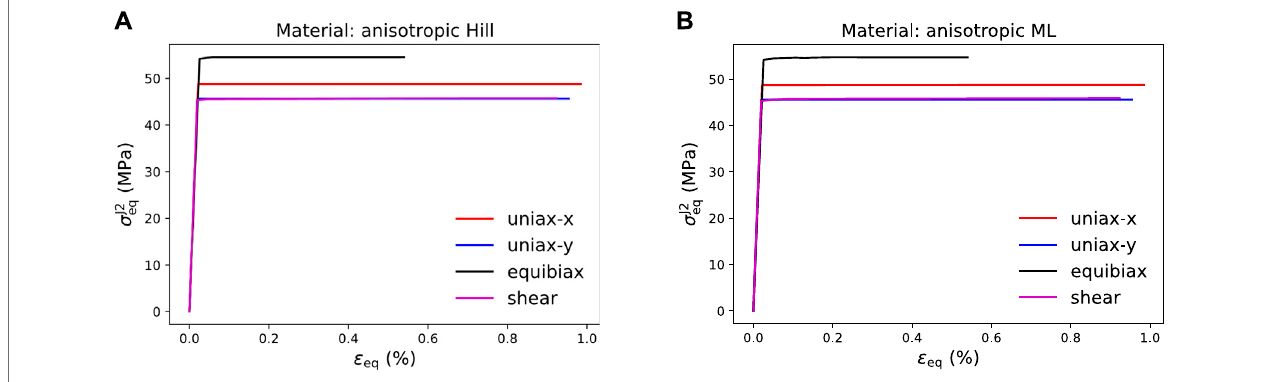
FIGURE 12 | Stress-strain curves obtained for elastic-ideal plastic material behavior under the loading conditions speci fi ed in the legend. (A) Equivalent J2 stress vs. equivalent total strain for Hill-type yield function, (B) Equivalent J2 stress vs. equivalent total strain for ML yield function.